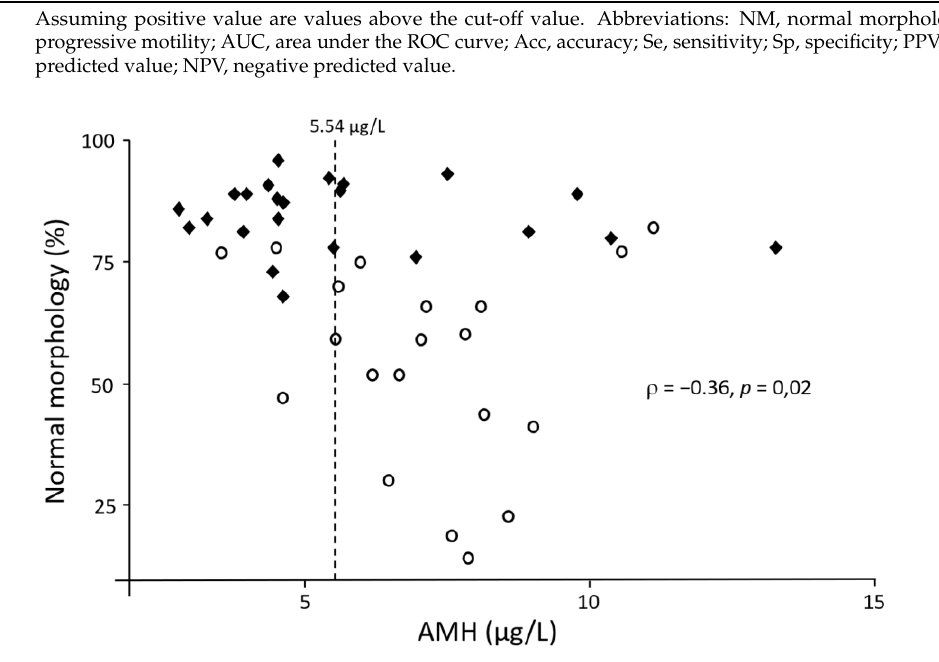
Figure 1. Scatter plot showing the relationship between serum AMH and the percentage of spermatozoa with a normal morphology. The dashed line represents the optimal cut-off value considering 60% normal morphology and 70% progressive motility as threshold values. Full diamonds represent dogs above these threshold values and empty circles represent dogs with at least one of the two parameters below these threshold values.